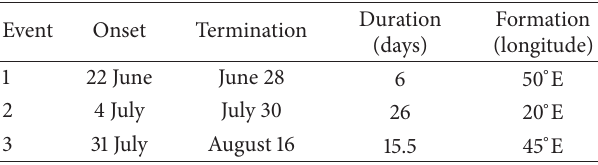
Table 2: Blocking events occurring during the summer of 2010 and identified by